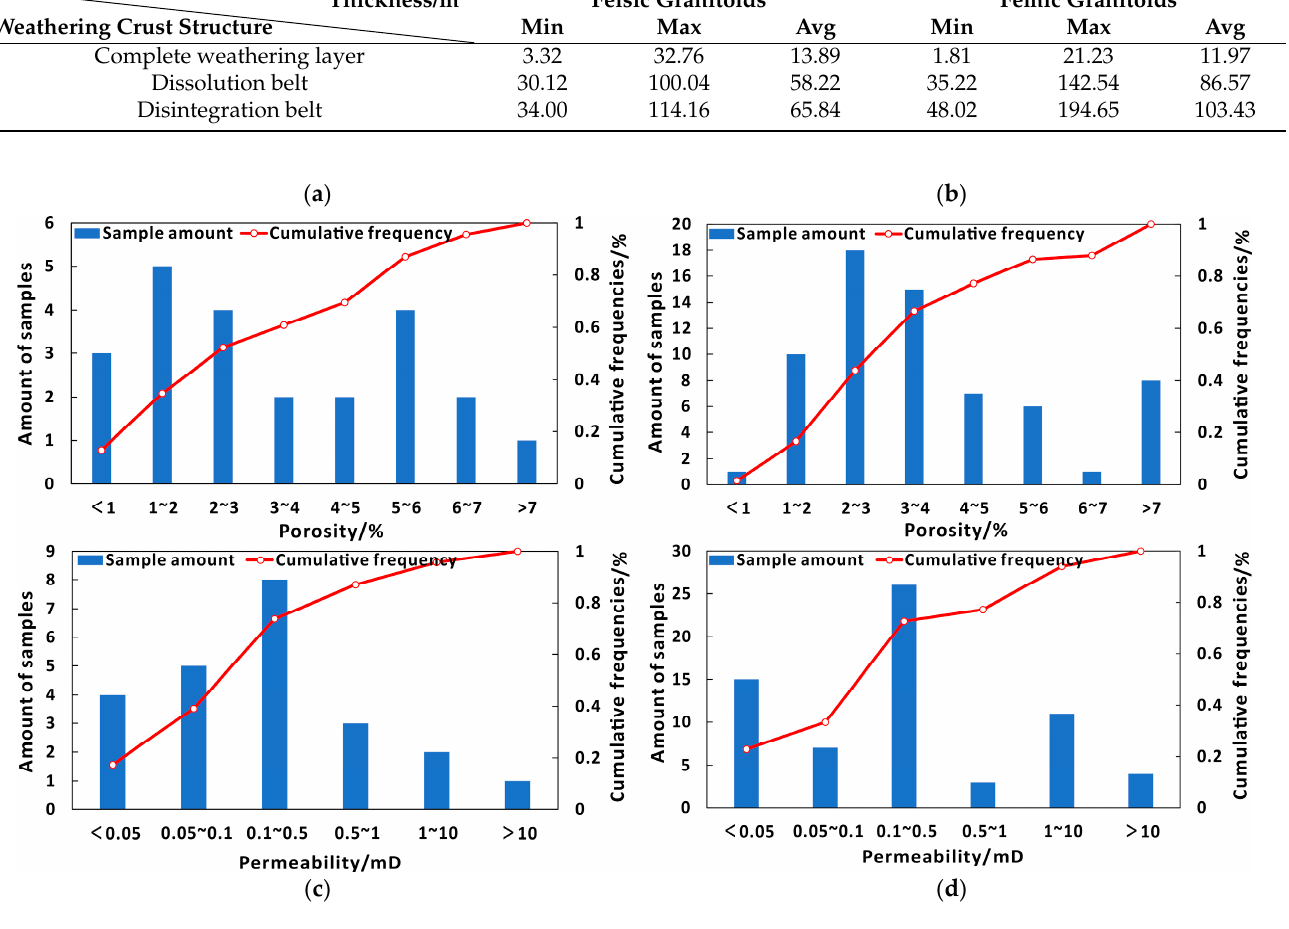
Figure 11. Physical properties of granite and granitic gneiss. ( a ) The distribution of porosity of granite; ( b ) the distribution of porosity of granitic gneiss; ( c ) the distribution of permeability of granite; ( d ) the distribution of permeability of granitic